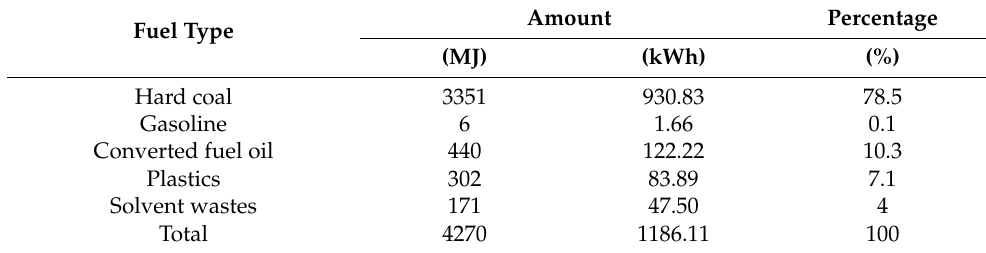
Table 5. Thermal energy fuel consumption per ton of OPC